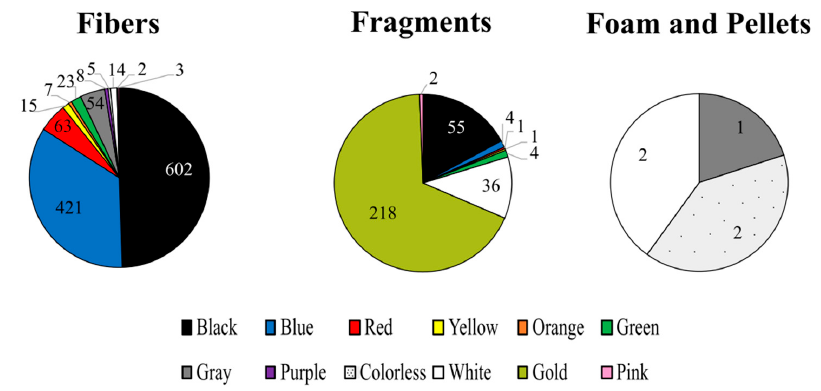
Figure 5. Number of MP particles in terms of shape and color, present in the surface water from Luruaco Lake, Atlántico, Colombia.